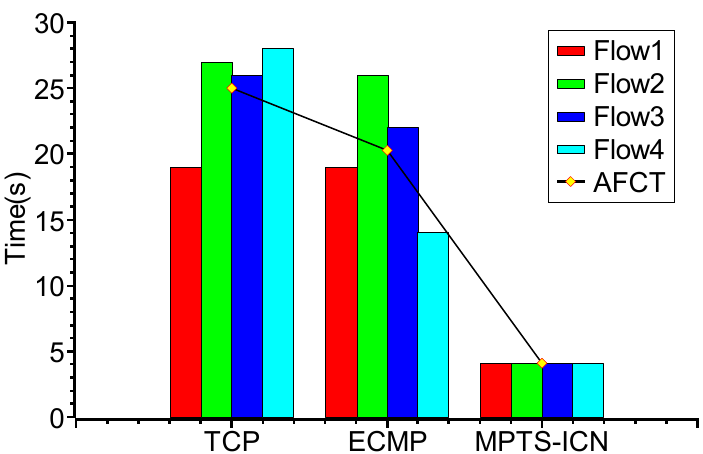
Figure 13. Data Transmission Completion Time under Different Data Transmission